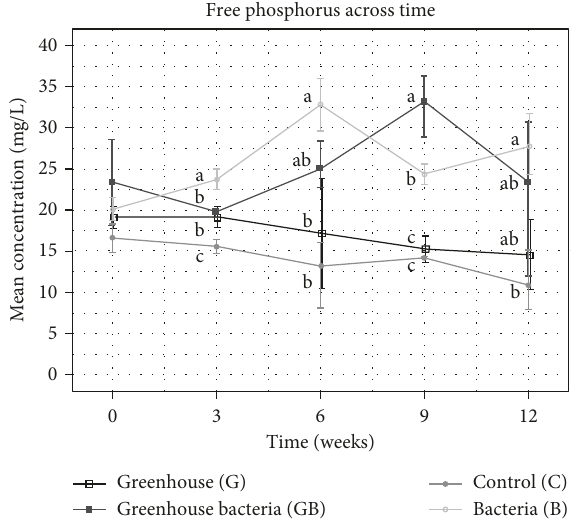
Figure 1: Free phosphorus concentrations per treatment across time. Means within a time measured followed by the same letter are not significantly different according to the Tukey–Kramer test or Nemenyi test in case of no normality.